Question: Identify the chart type used in this figure.
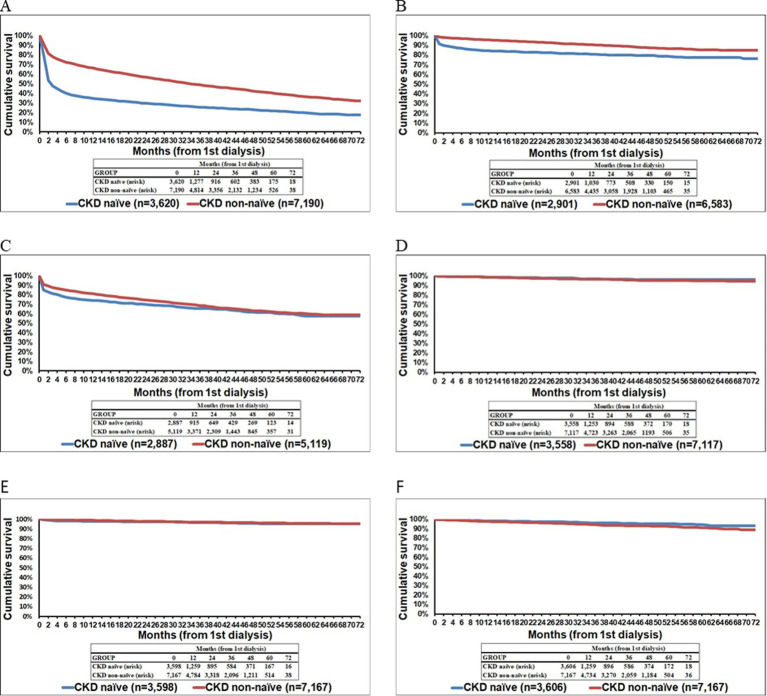
Answer: survival